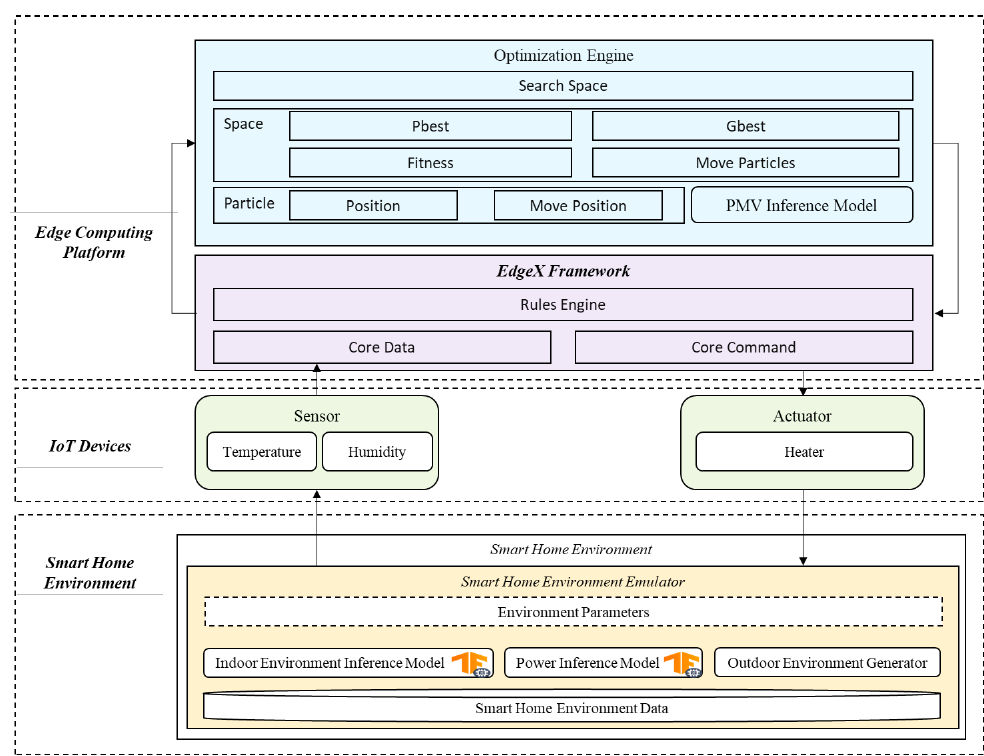
Figure 2. Proposed Configuration of Smart Homes based on PSO Optimization Scheme. Table 1. The Factors of PMV Inference